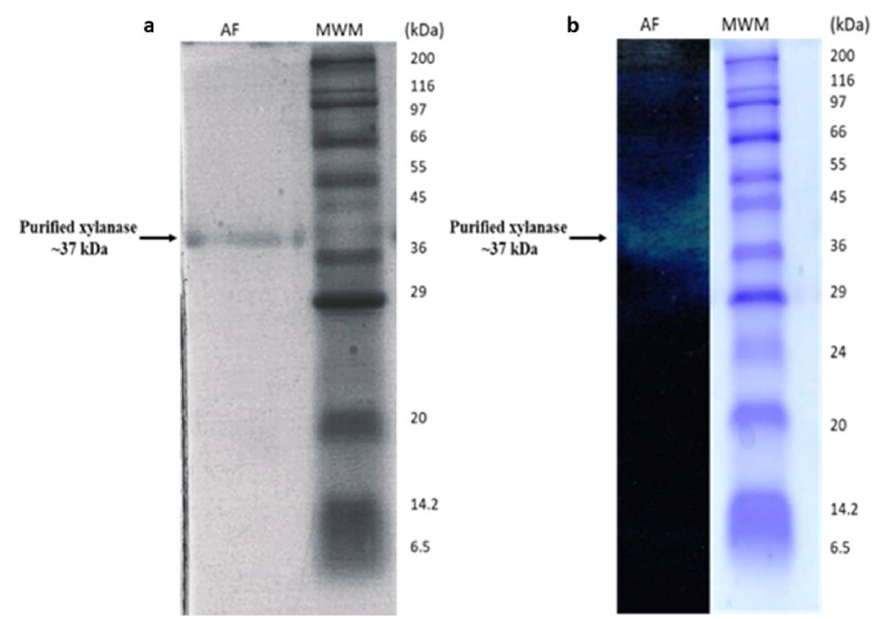
Figure 1. ( a ) Beauveria bassiana SAN01 xylanase on 12% SDS-PAGE gel. Lane AF: Active fraction, MWM: Wide range protein marker (ThermoFisher Scientific 6.5–200 kDa) ( b ) Xylanase activity on Native PAGE gel containing 0.5% beechwood xylan, AF: Active fraction, MWM: Wide range protein marker (ThermoFisher Scientific 6.5–200 kDa).